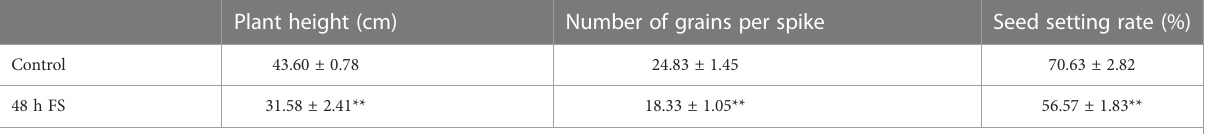
Data are mean ± SE calculated from six biological replicates. ** indicates a signi fi cant difference (p-value < 0.01) using a Student ’ s